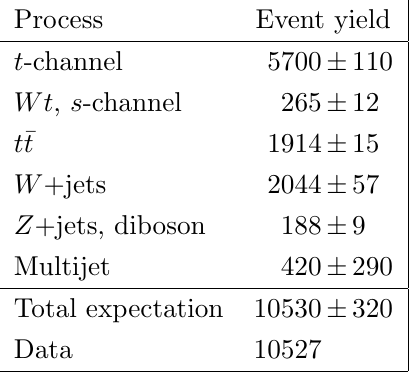
Table 3. Signal and background event yields in the signal region after scaling to the results of the maximum-likelihood (cid:12)t. The quoted uncertainties add in quadrature the post-(cid:12)t uncertainties and the uncertainties due to the limited size of the simulation samples, except for the data-driven mul- tijet contribution to which the normalisation uncertainty of 70% is applied. The total expectation is compared to the observed number of